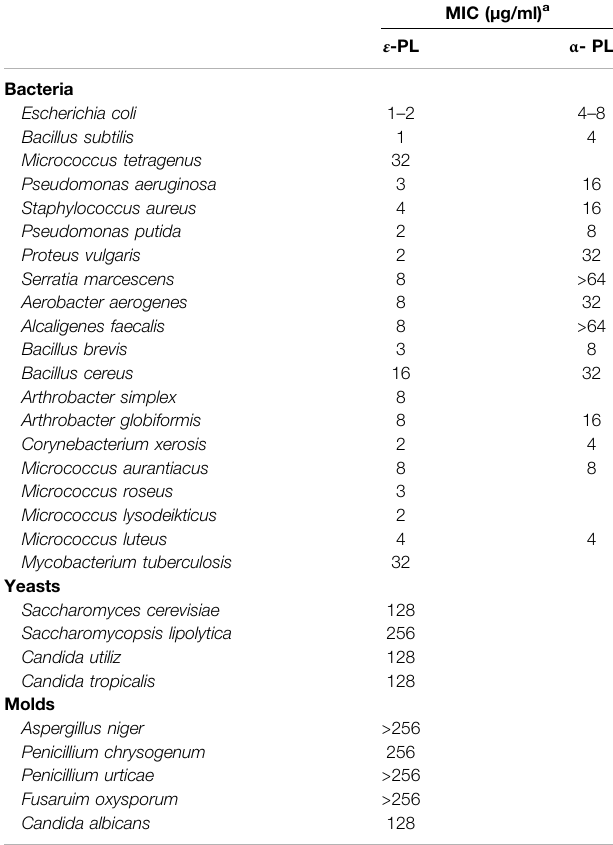
TABLE 3 | Antimicrobial activity of ε